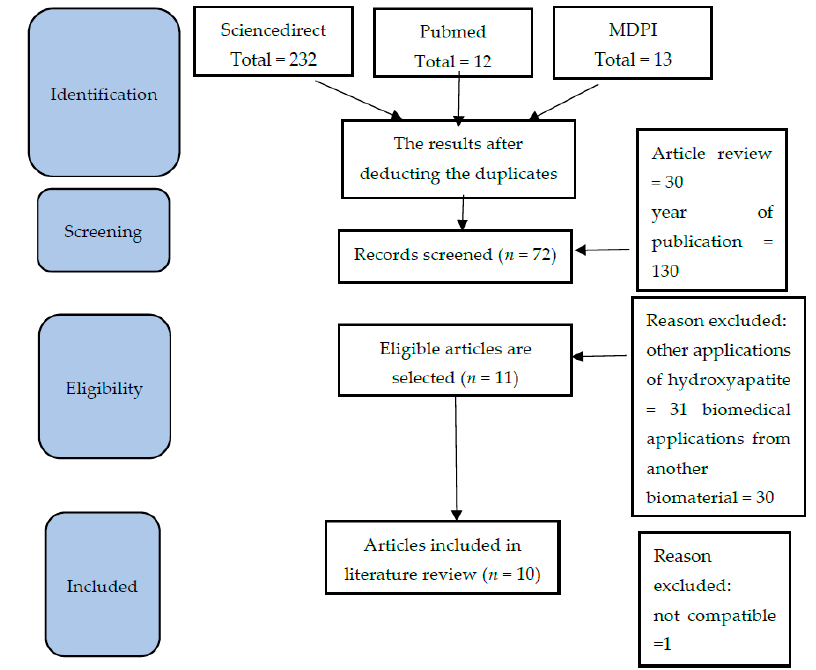
Figure 1. Literature Review Search Method.